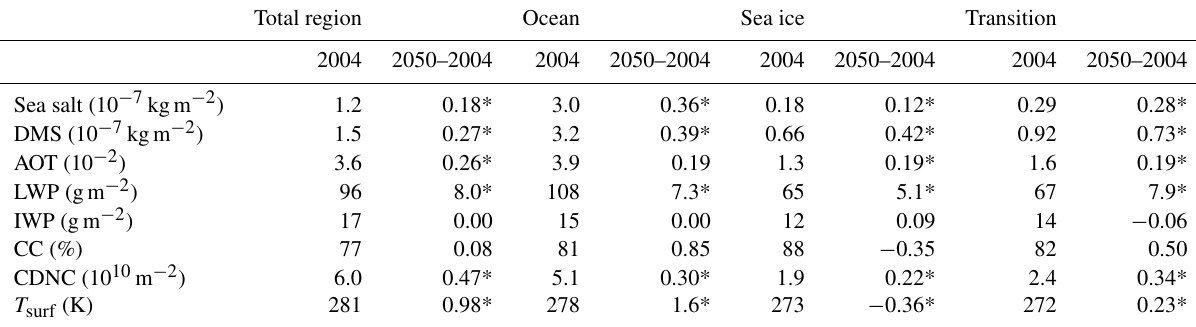
Figure 3. Aerosol number size distributions in 2004 (arctic_2004) and 2050 (arctic_2050_EM2004); N stands for the number concentration (assuming that air density ρ air ≈ 1kgm 3 ), r ap for the radius of the aerosol particles. The size distributions are shown for early autumn (September–October) at 950hPa (a) and 800hPa (b) , averaged between 75 and 90 ◦ N. The solid lines denote ensemble means, the dotted lines the subtracted/added standard deviations. Different colours (black, green) stand for different simulations (see legend). Table 2. Absolute values for the year 2004 and differences between 2050 and 2004 (i.e. between simulations arctic_2050_EM2004 and arctic_2004) for sea salt burden, DMS burden, AOT, LWP, IWP, cloud cover (“CC”), in-cloud CDNC burden, and T surf for late summer (July–August). The numbers are averaged over four regions between 60 and 90 ◦ N: (i) the whole region, (ii) grid boxes which are ocean in both 2004 and 2050 (SIC < 0 . 5; “Ocean”), (iii) grid boxes which are covered by sea ice in both 2004 and 2050 (SIC > 0 . 5; “Sea ice”), and (iv) grid boxes which have sea ice in 2004 (SIC > 0 . 5) but not in 2050 (SIC < 0 . 5; “Transition”). Significant changes are marked with a star. Note that the SST is prescribed, i.e. shows no inter-annual variability. Total region Ocean Sea